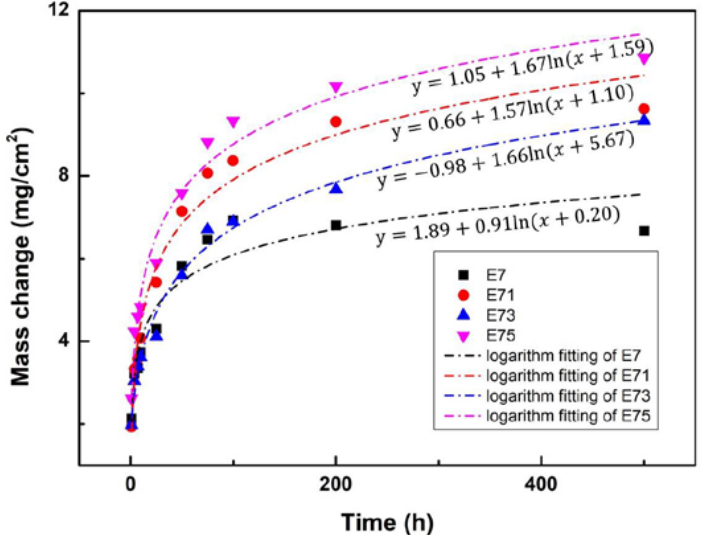
Figure 3. Oxidation kinetic curves of the E7, E71, E73 and E75 alloys after isothermal oxidation at 1000 °C.